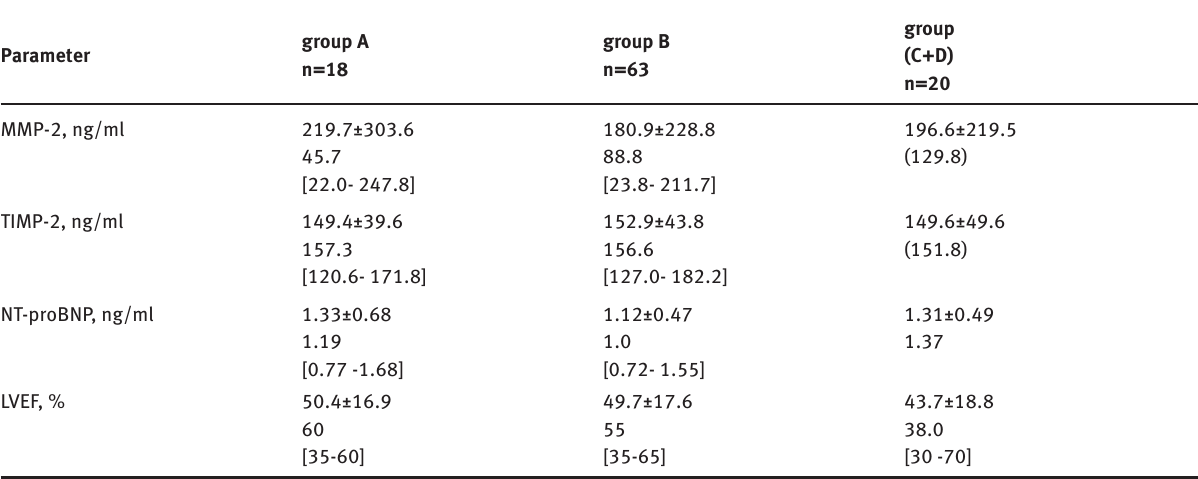
Table 3: The serum levels of MMP-2, TIMP-2, NT-proBNP, and LVEF in A, B, and C groups (classification according to the degree of diastolic dysfunction, evaluated by ultrasonography).